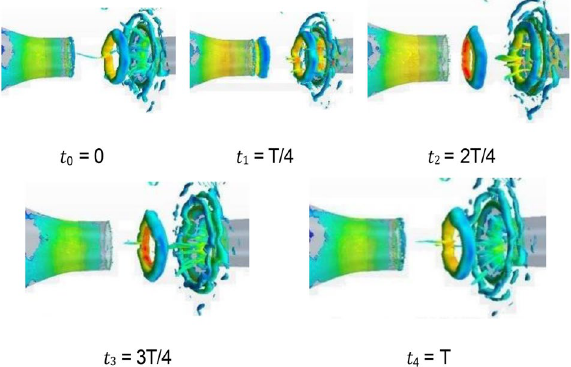
Figure 20. The isosurface cloud diagram of Q criterion of the simplified model (Q = 200 /s 2 ).